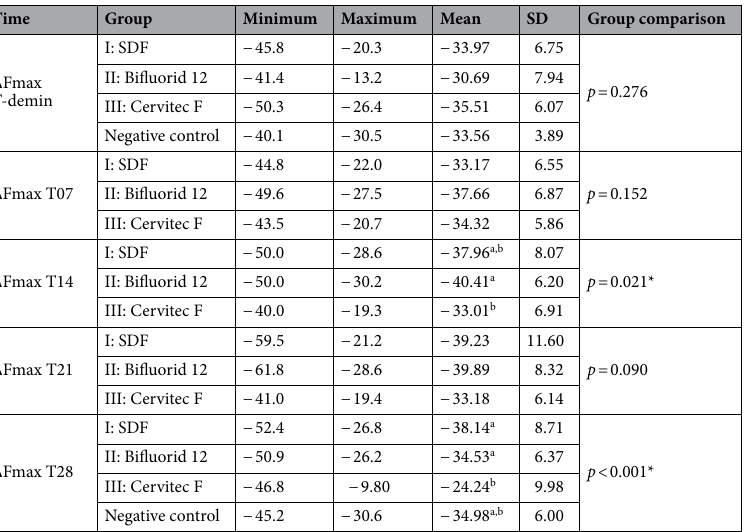
Table 2. Results of the QLF measurements in different groups: ΔF max (fluorescence loss [%]) shows the highest value of ΔF measured within the region of interest and is an indication for the maximum lesion depth (SD: standard deviation). *Different superscript letters indicate significant differences between the